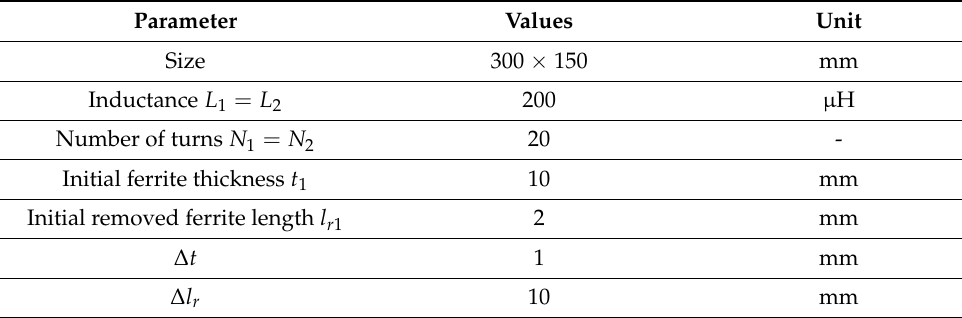
Table 6. Parameters for the ferrite of a DD coupler in a 3D simulation.